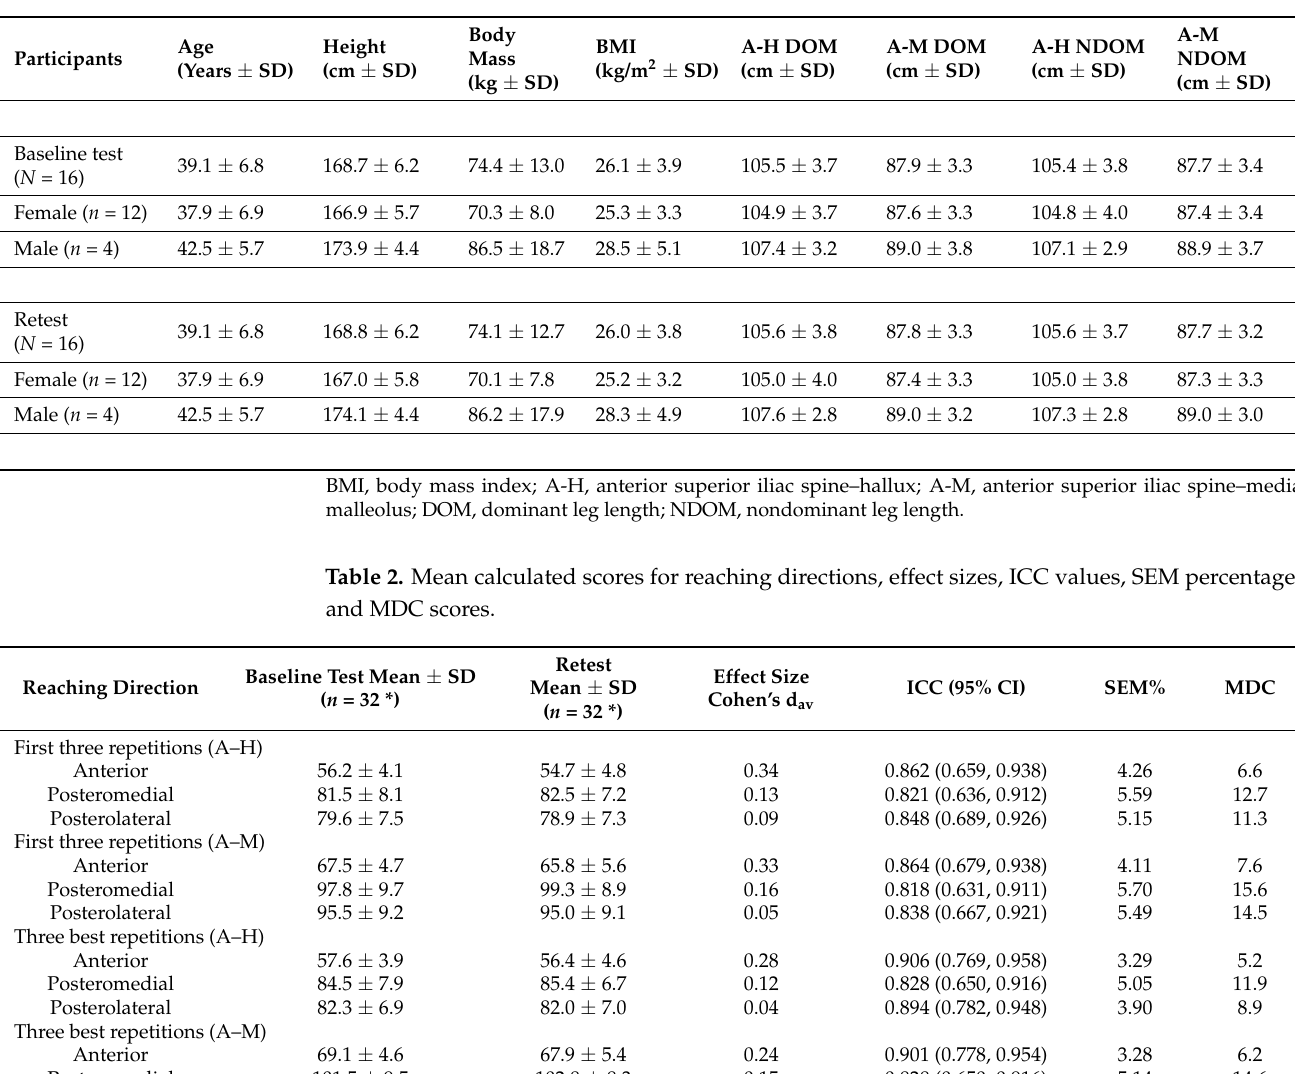
Table 1. Study participant characteristics.